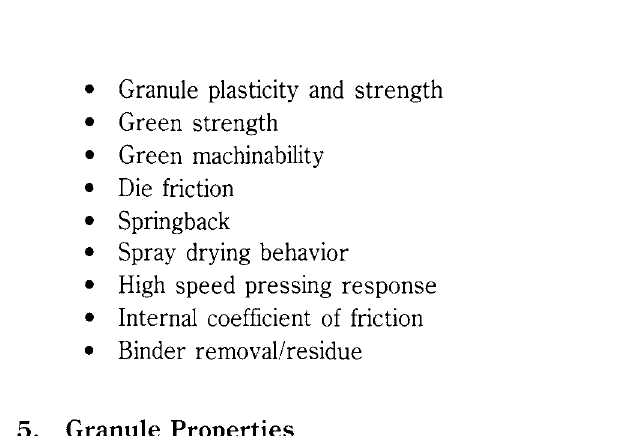
Fig. 1 Generic shapes of compaction curves. Curve 1, powder without aggregates that has not been spray dried. Curve 2, powder containing aggregates which are weak enough to be broken during compaction and has not been spray dried. Curve 3, metal powder that exhibits plastic deformation at particle-particle contacts. Curve 4, spray dried powder without aggregates. Curve 5, spray dried powder that contains aggregates which can be broken during